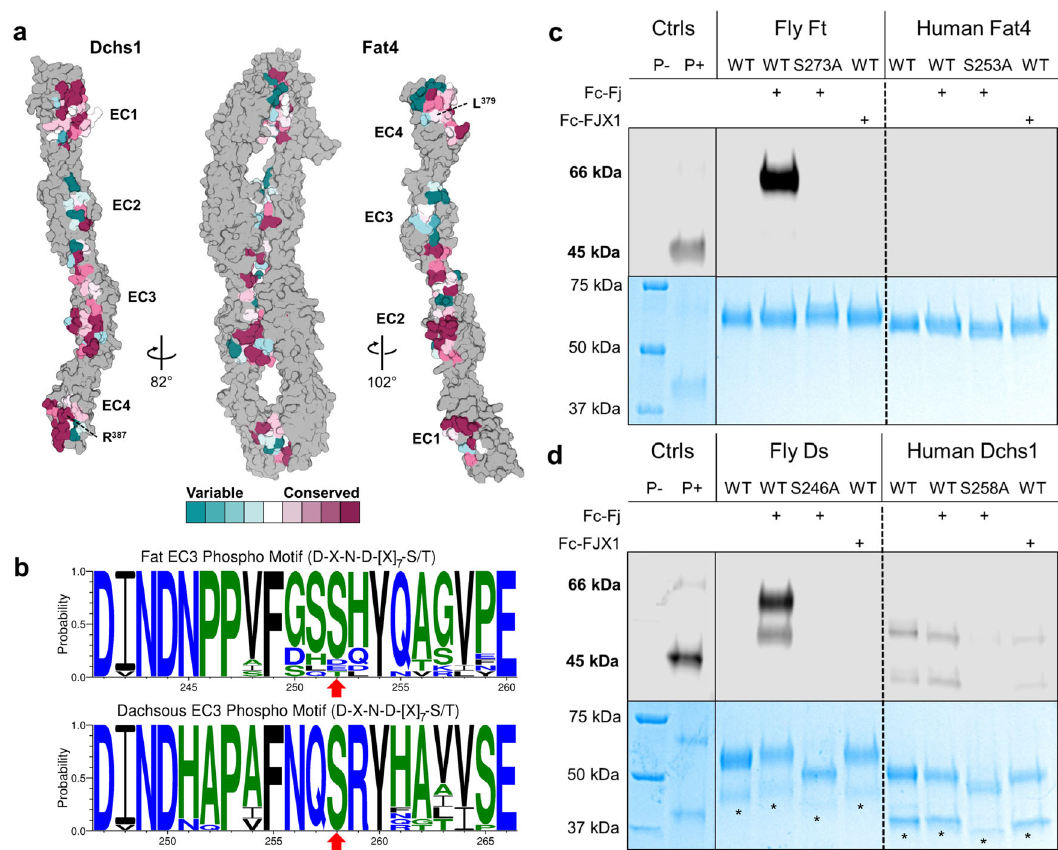
Fig. 5 | Interface and phosphomotif conservation in Fat and Dachsous. a ConservationanalysisoftheFat4andDchs1bindinginterface.TheEC1-4domains of each protein are depictedin surface representation and interacting residues are colored based on their conservation across 18 different Fat4 or Dchs1 homologs. b A multiple sequence alignment of the Fj phosphorylation motif (D-X-N-D-[X] 7 -S/ T) in EC3 of Fat4 and Dchs1 is shown as a sequence logo. The predicted phos- phoserine residue is indicated with a red arrow. The motif is mostly conserved in Fat4 and Dchs1 homologs. c,d . SDS-PAGE analysis of Fat4(EC1 – 4), Dchs1(EC1 – 4), Ft(EC1 – 4), and Ds(EC1 – 4) proteins following incubation with Fj and FJX1. The gels werestainedwithCoomassietomonitortotalprotein(bottompanel,coloredblue)